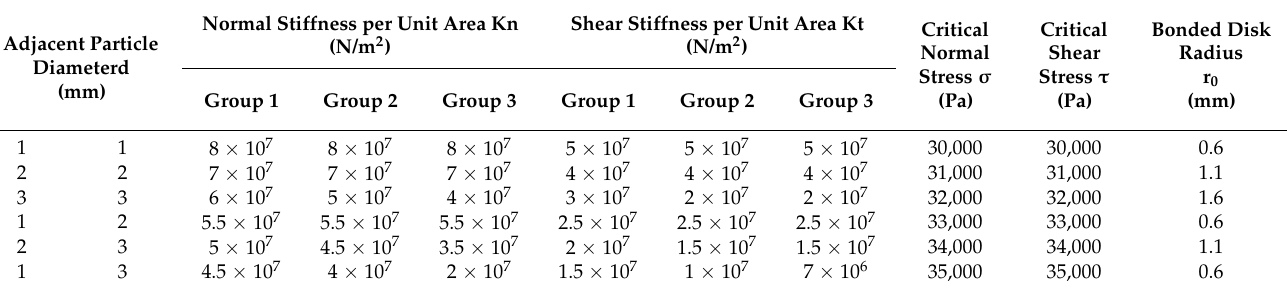
Table 3. Parameters of the bonds between particles.